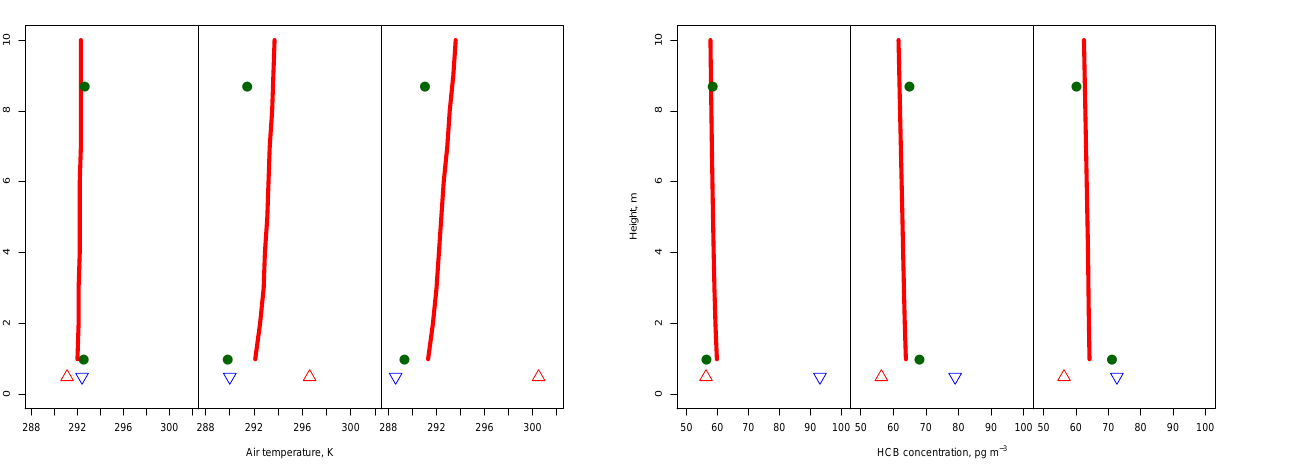
Fig. 6. Measured (circles) and IBLTE modeled (line) HCB atmo- spheric concentration at the 15-, 30-, and 60-km stations (panels from left to right). The HCB concentration at equilibrium with the water surface is plotted as a downward-pointing blue triangle, and the initial over-land HCB concentration as an upward-pointing red triangle. An increase in HCB atmospheric concentration with fetch was observed at 1-m height, consistent with model prediction based on the aqueous HCB concentration of Environment Canada, but not with the lower aqueous concentration of Simcik et al. (2010). The Environment Canada concentration was used in this